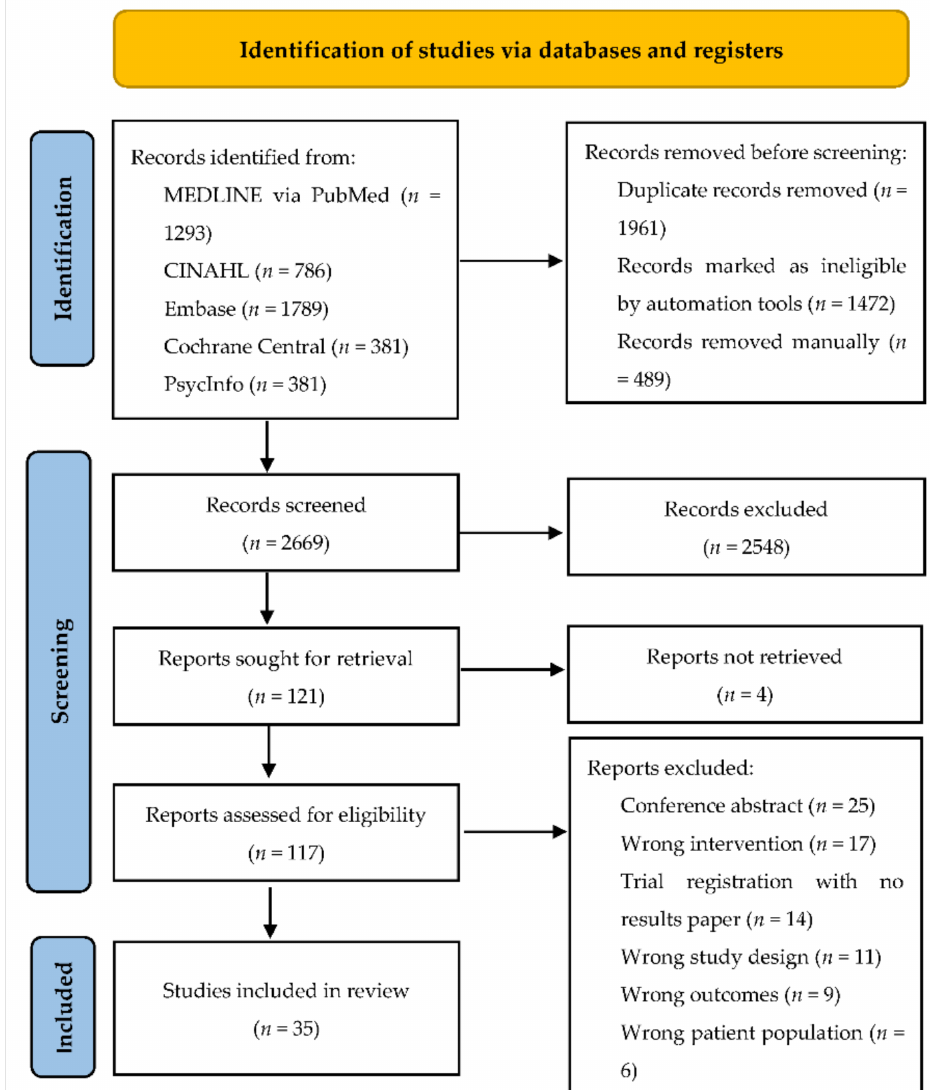
Figure 1. PRISMA flow diagram for our systematic